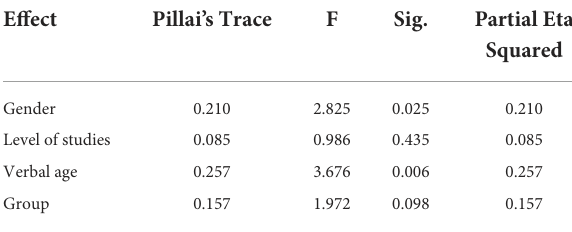
TABLE 3 Multivariate analysis of covariance (MANCOVA) comparing ToM subdomain scores in children with autism spectrum disorder to age and mental age-matched